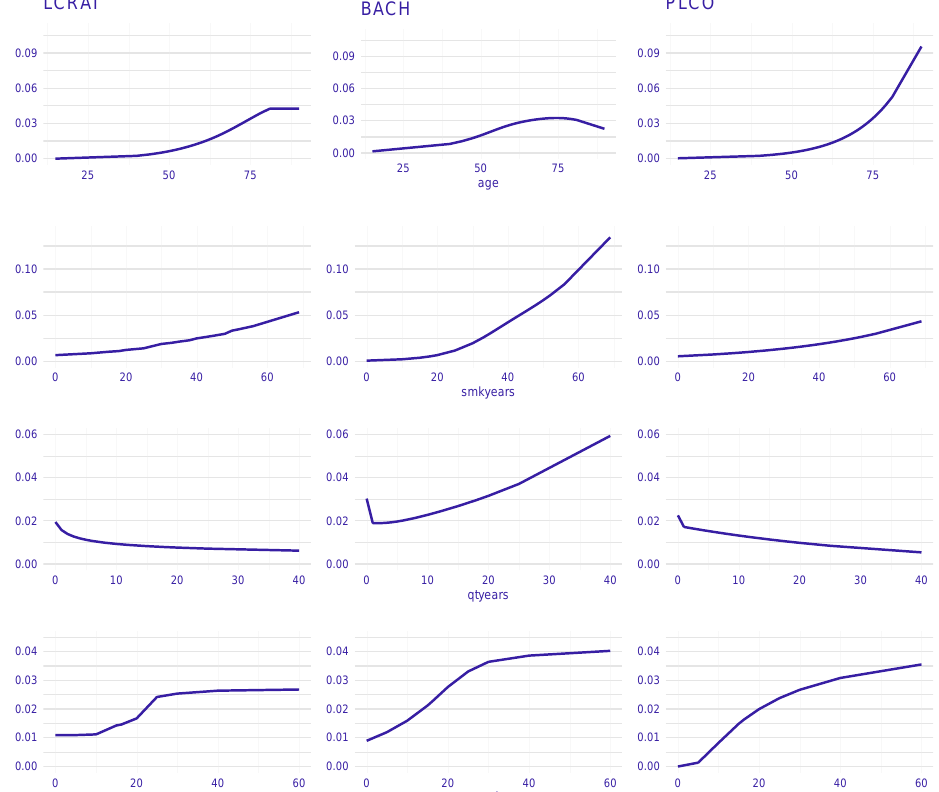
Figure 3. Partial Dependence Profiles illustrate the relationship between a variable and an average model prediction. On the x -axis, the range of available values of the analyzed variable is shown, while on the y -axis, the values of the mean prediction are